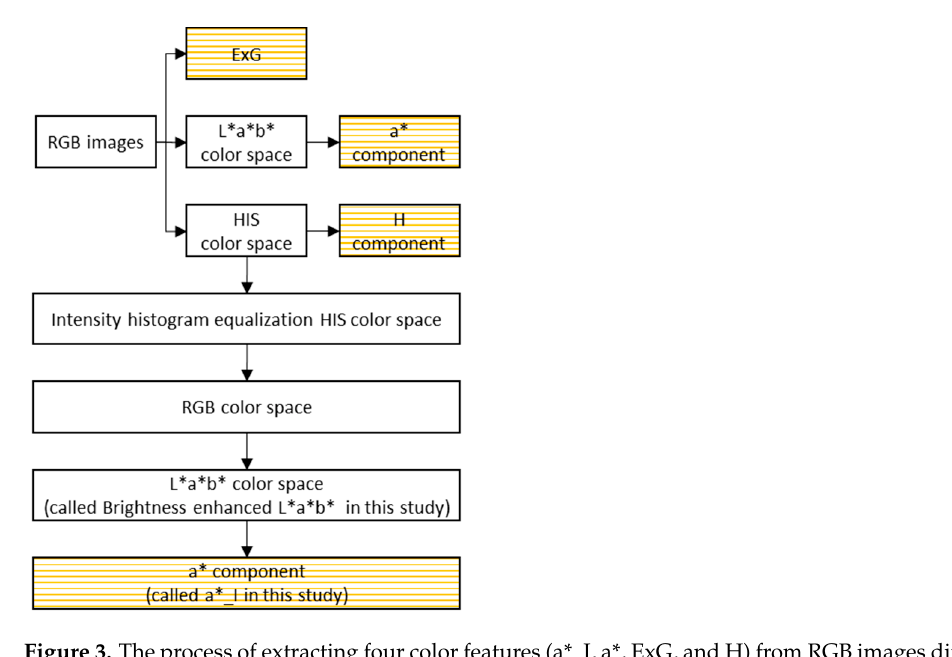
Figure 3. The process of extracting four color features (a*_I, a*, ExG, and H) from RGB images directly and indirectly.